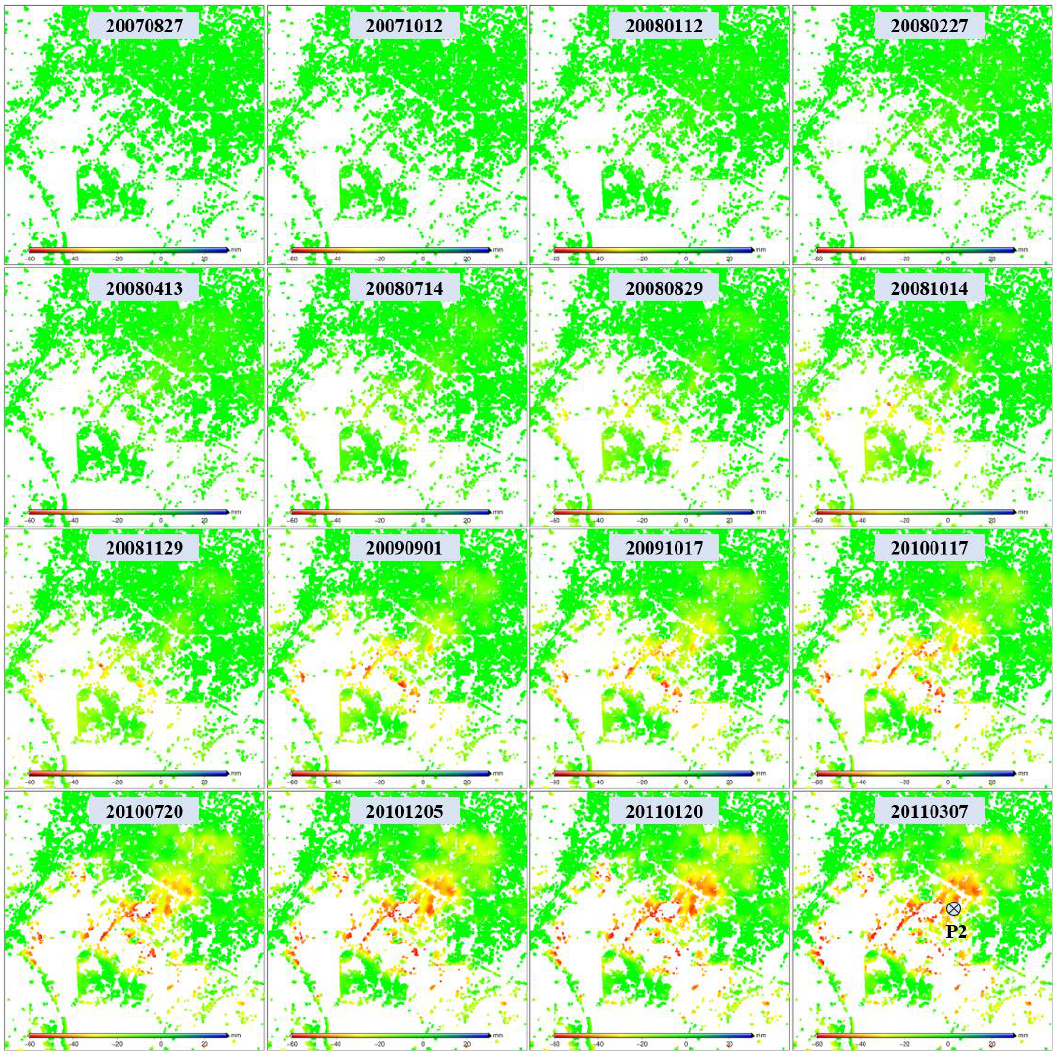
Figure 13. Time series deformation in Xishan (marked with black rectangles in Figure 5) observed using L-band ALOS-1 images. The time series deformation at point P2 will be extracted for further analysis.